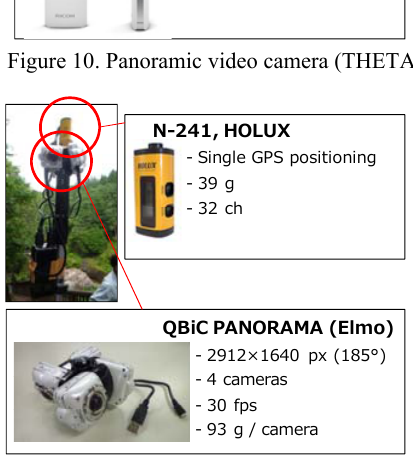
Figure 11. Panoramic video camera (QBiC)